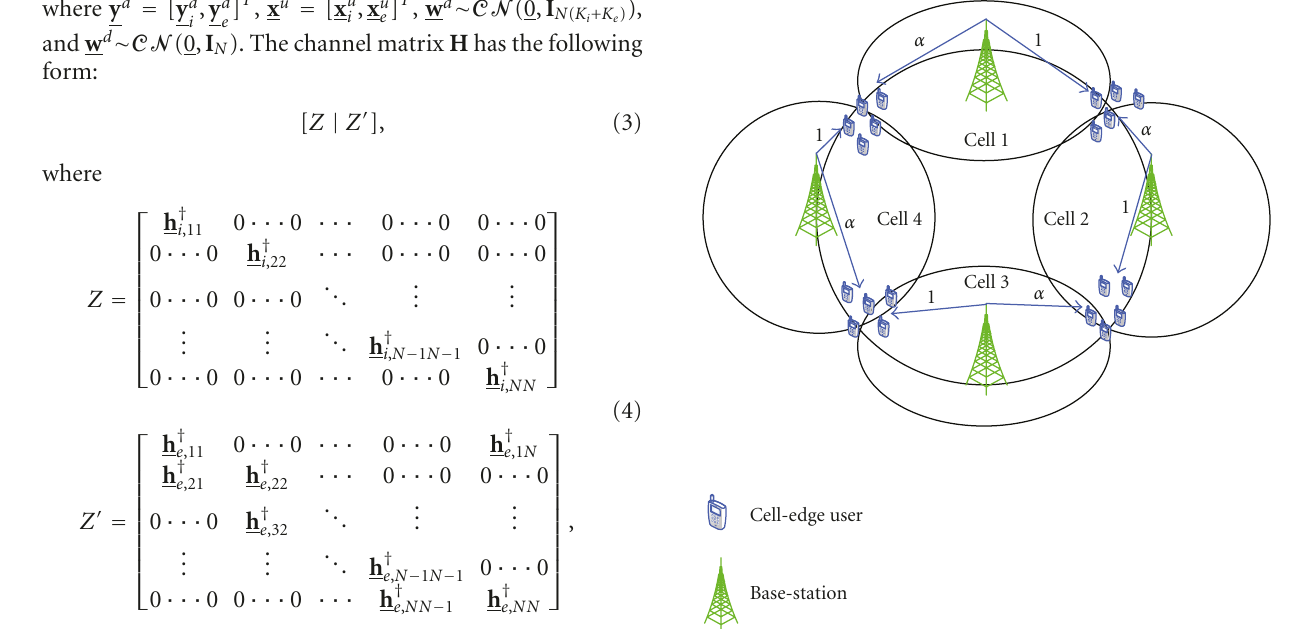
Figure 2: (4,5) single-class